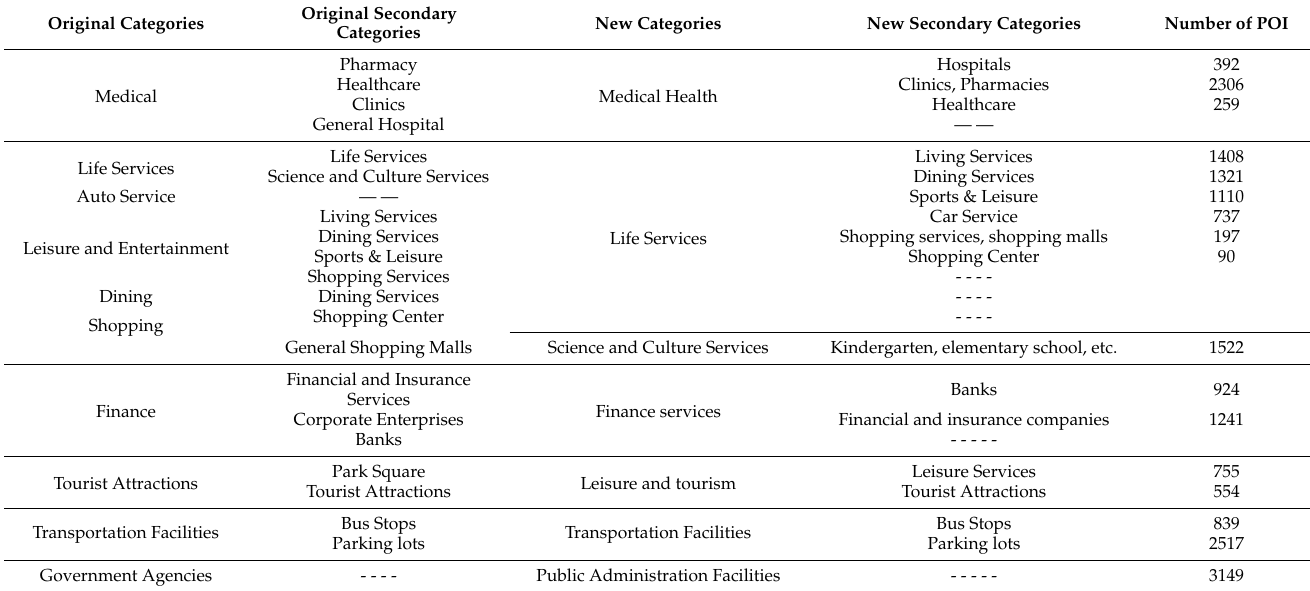
Table 5. Reclassified POI system.